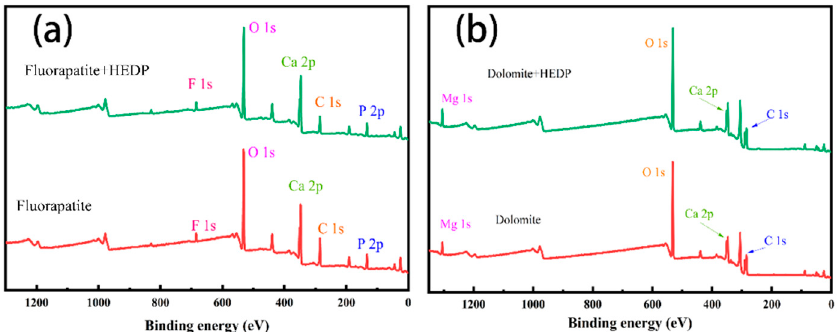
Figure 9. XPS wide-scan spectra of fluorapatite ( a ) and dolomite ( b ) before and after reaction with HEDP and NaOL.